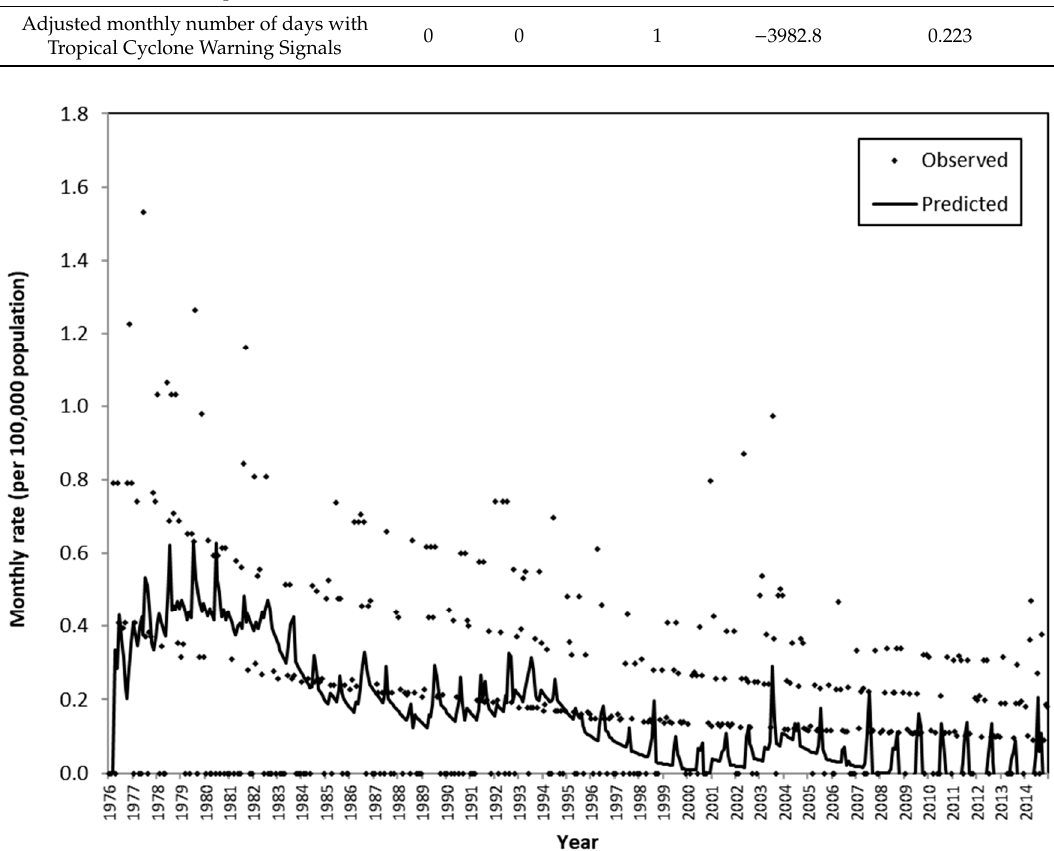
Figure 3. The observed rate of older-adult suicide mortality from nonviolent methods and the predicted rate based on the transfer function model that featured an adjusted monthly number of days with daily maximum ambient temperature exceeding 32.7 °C as the input series.